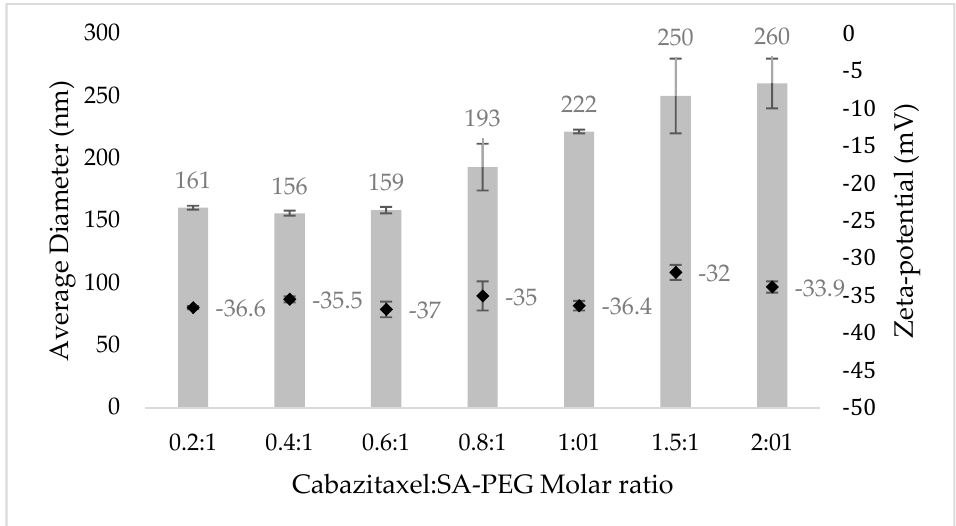
Figure 4. Mean diameter and zeta-potential of NPs at increasing CTX: SA-PEG molar ratios. Columns represent the mean diameter and black diamonds represent the zeta-potential. Values presented are means ± SE, n = 2 (two independent experiments, each performed in triplicates).